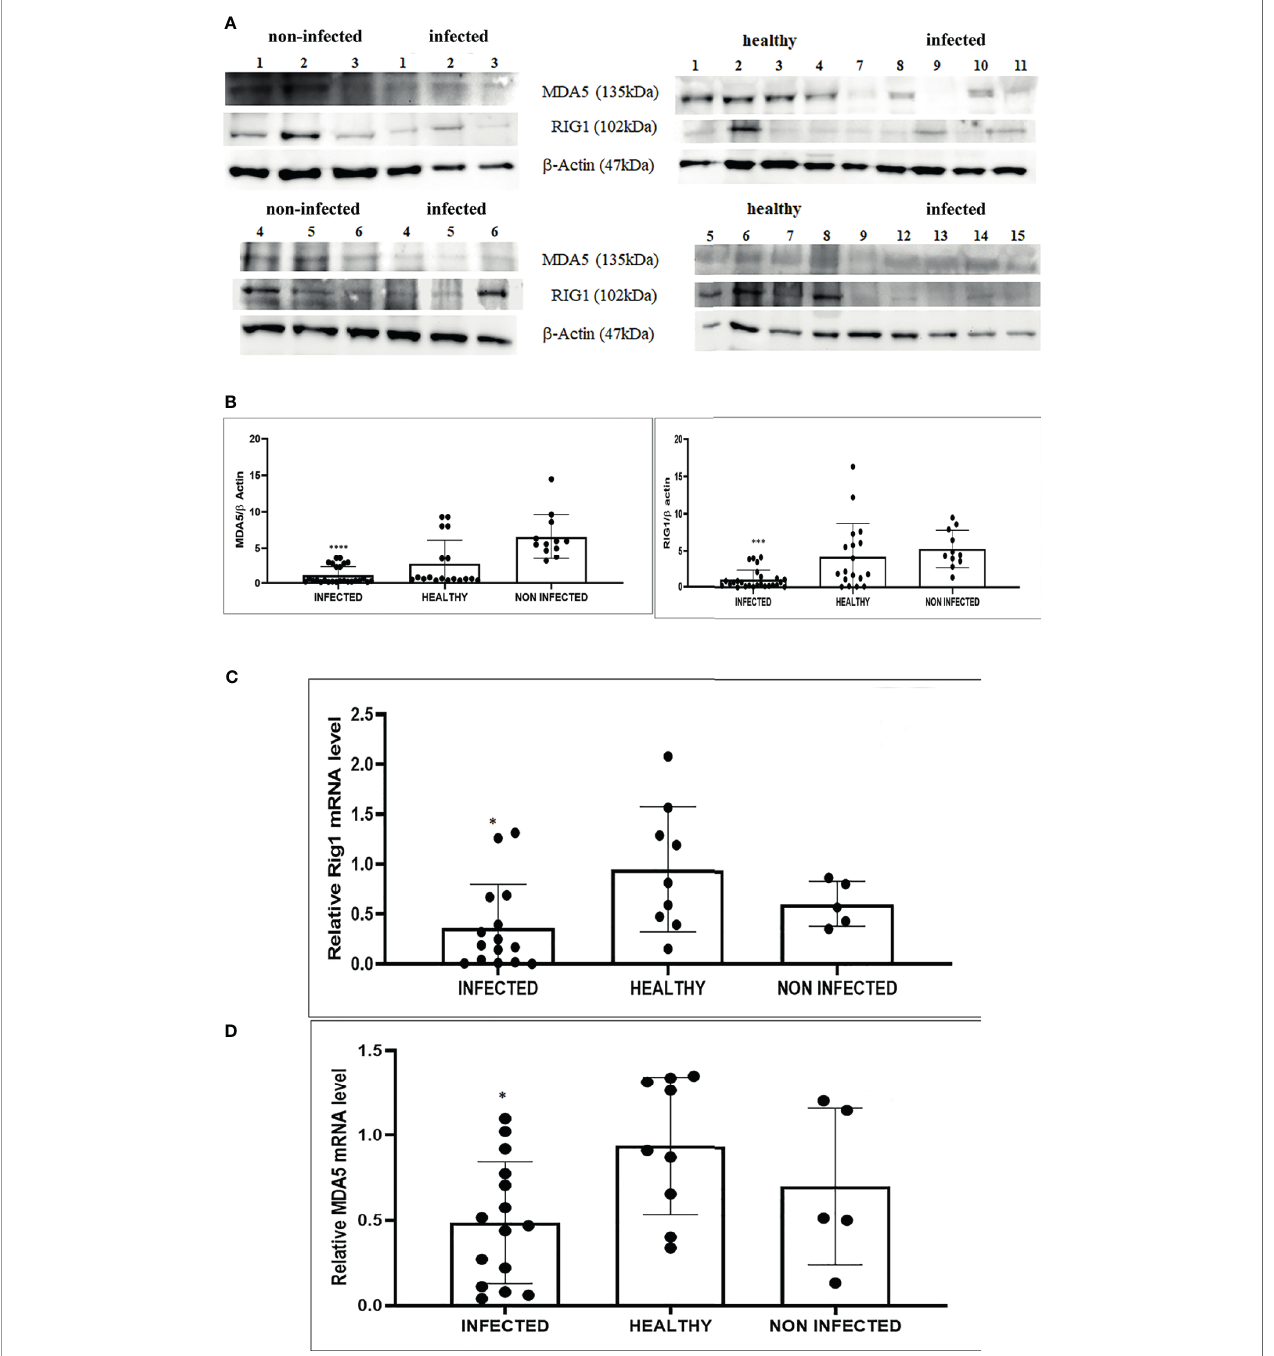
FIGURE 3 | (A) Western blot analysis of RIG-1 and MDA5 in infected, healthy and non-infected but in fl ammatory bladder samples. (B) Densitometric analysis was performed by comparing the protein expression levels of total RIG-1 and MDA5 with those of b -actin. RIG-1 and MDA5 protein levels were signi fi cantly reduced in the infected mucosa samples compared with both healthy and uninfected samples. (***p ≤ 0.001; ****p ≤ 0.0001). Plots represent value found in each sample performed in duplicate. (C, D) Real-time RT-PCR analysis of RIG-I and MDA5 mRNA levels, respectively, in infected, healthy and non-infected but in fl ammatory bladder samples. RIG-I and MDA5 mRNA expressions were signi fi cantly reduced in diseased bladder samples compared with both healthy and uninfected bladder (*p ≤ 0.05). Plots represent value found in each sample performed in